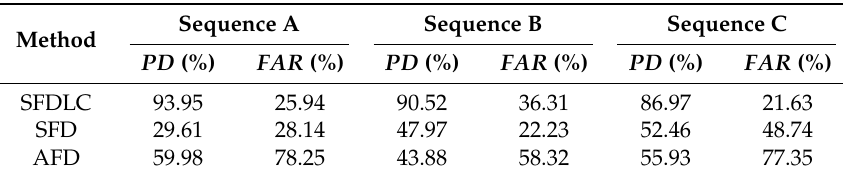
Table 2. Quantitative evaluation of moving target detection.